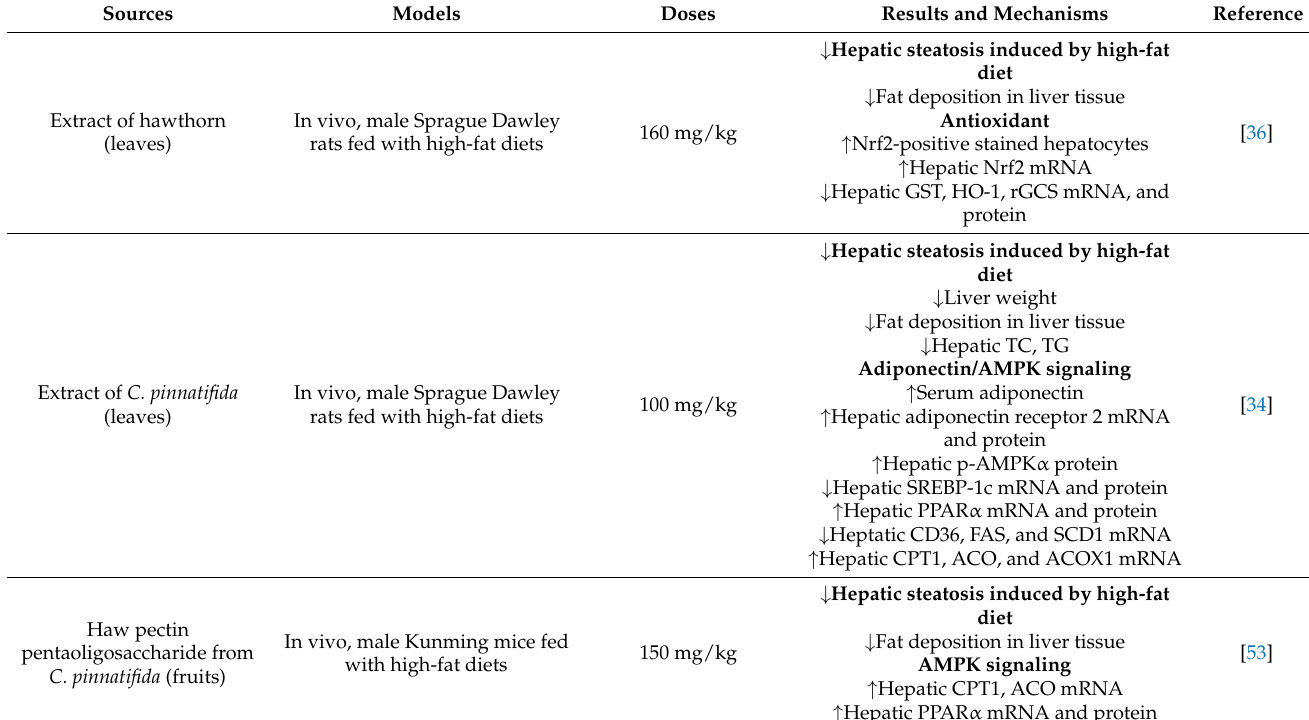
Figure 2. Inducer, rodent, hawthorn species, experimental results, and underlying mechanism of preclinical studies on hawthorn extract exhibiting antisteatotic activities related to liver pathogenesis. ApoE, apolipoprotein E; AMPK, AMP-activated protein kinase; LDL, low-density lipoprotein; MCD, methionine choline deficient; TC, total cholesterol; and TG, triglyceride. Table 2. Antisteatotic effects and molecular mechanisms of hawthorn